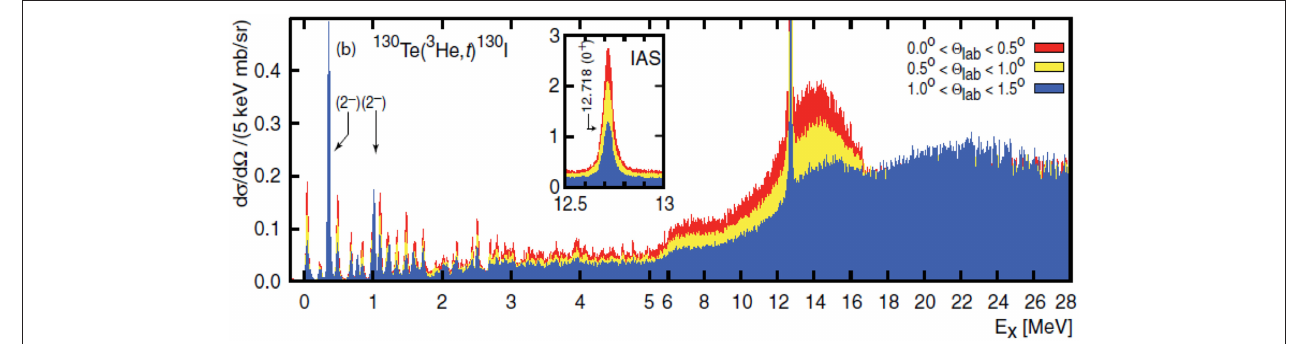
FIGURE 3 | Energy spectrum of the ( 3 He, t ) CER on 130 Te at several angles from 0 ◦ to 1.5 ◦ . The spectrum at each angle is folded on top of each